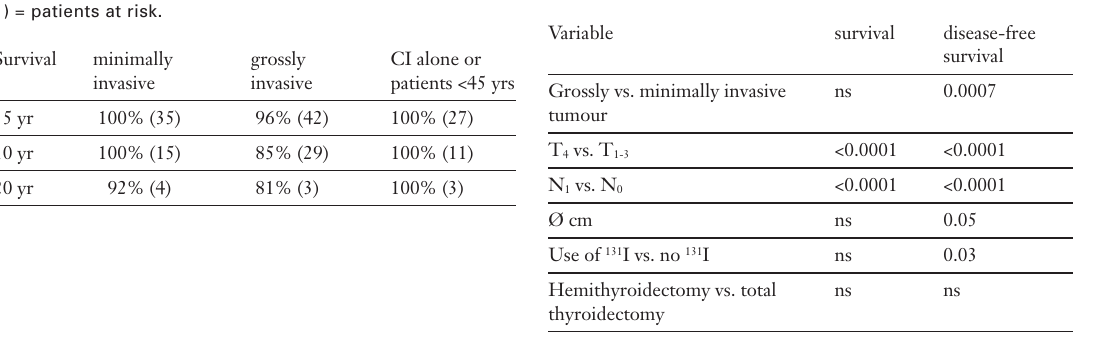
Risk factors in FTC by univariate Variable survival disease-free Grossly vs. minimally invasive